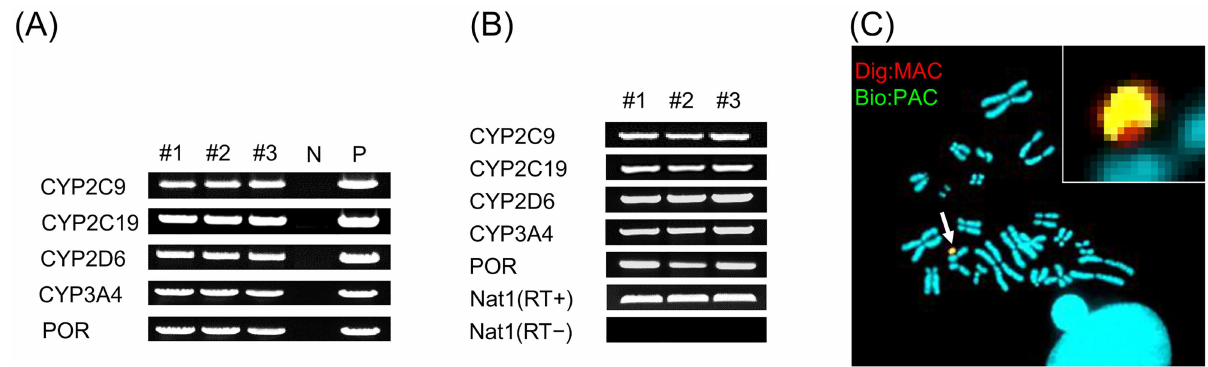
Fig 1. Construction and analysis of the 4CYPs-POR MAC vector in CHO cells. (A) Genomic PCR and (B) RT-PCR analysisof CHO cells containing the 4CYPs-POR MAC. N, negativecontrol (parentalCHO cells); P, positive control (PAC-4CYPs-POR). (C) FISH analysis of donor CHO cells containing the 4CYPs-POR MAC. Digoxigenin-labeledmouse cot-1 DNA (red) was used to detect the MAC. Biotin- labeled4CYPs-POR PAC (green)was used to detect the 4CYPs-POR cassette in the MAC. Chromosomal DNA was counterstained with DAPI. White arrow indicatesMAC vector, and the inset shows enlargedimage of the MAC.